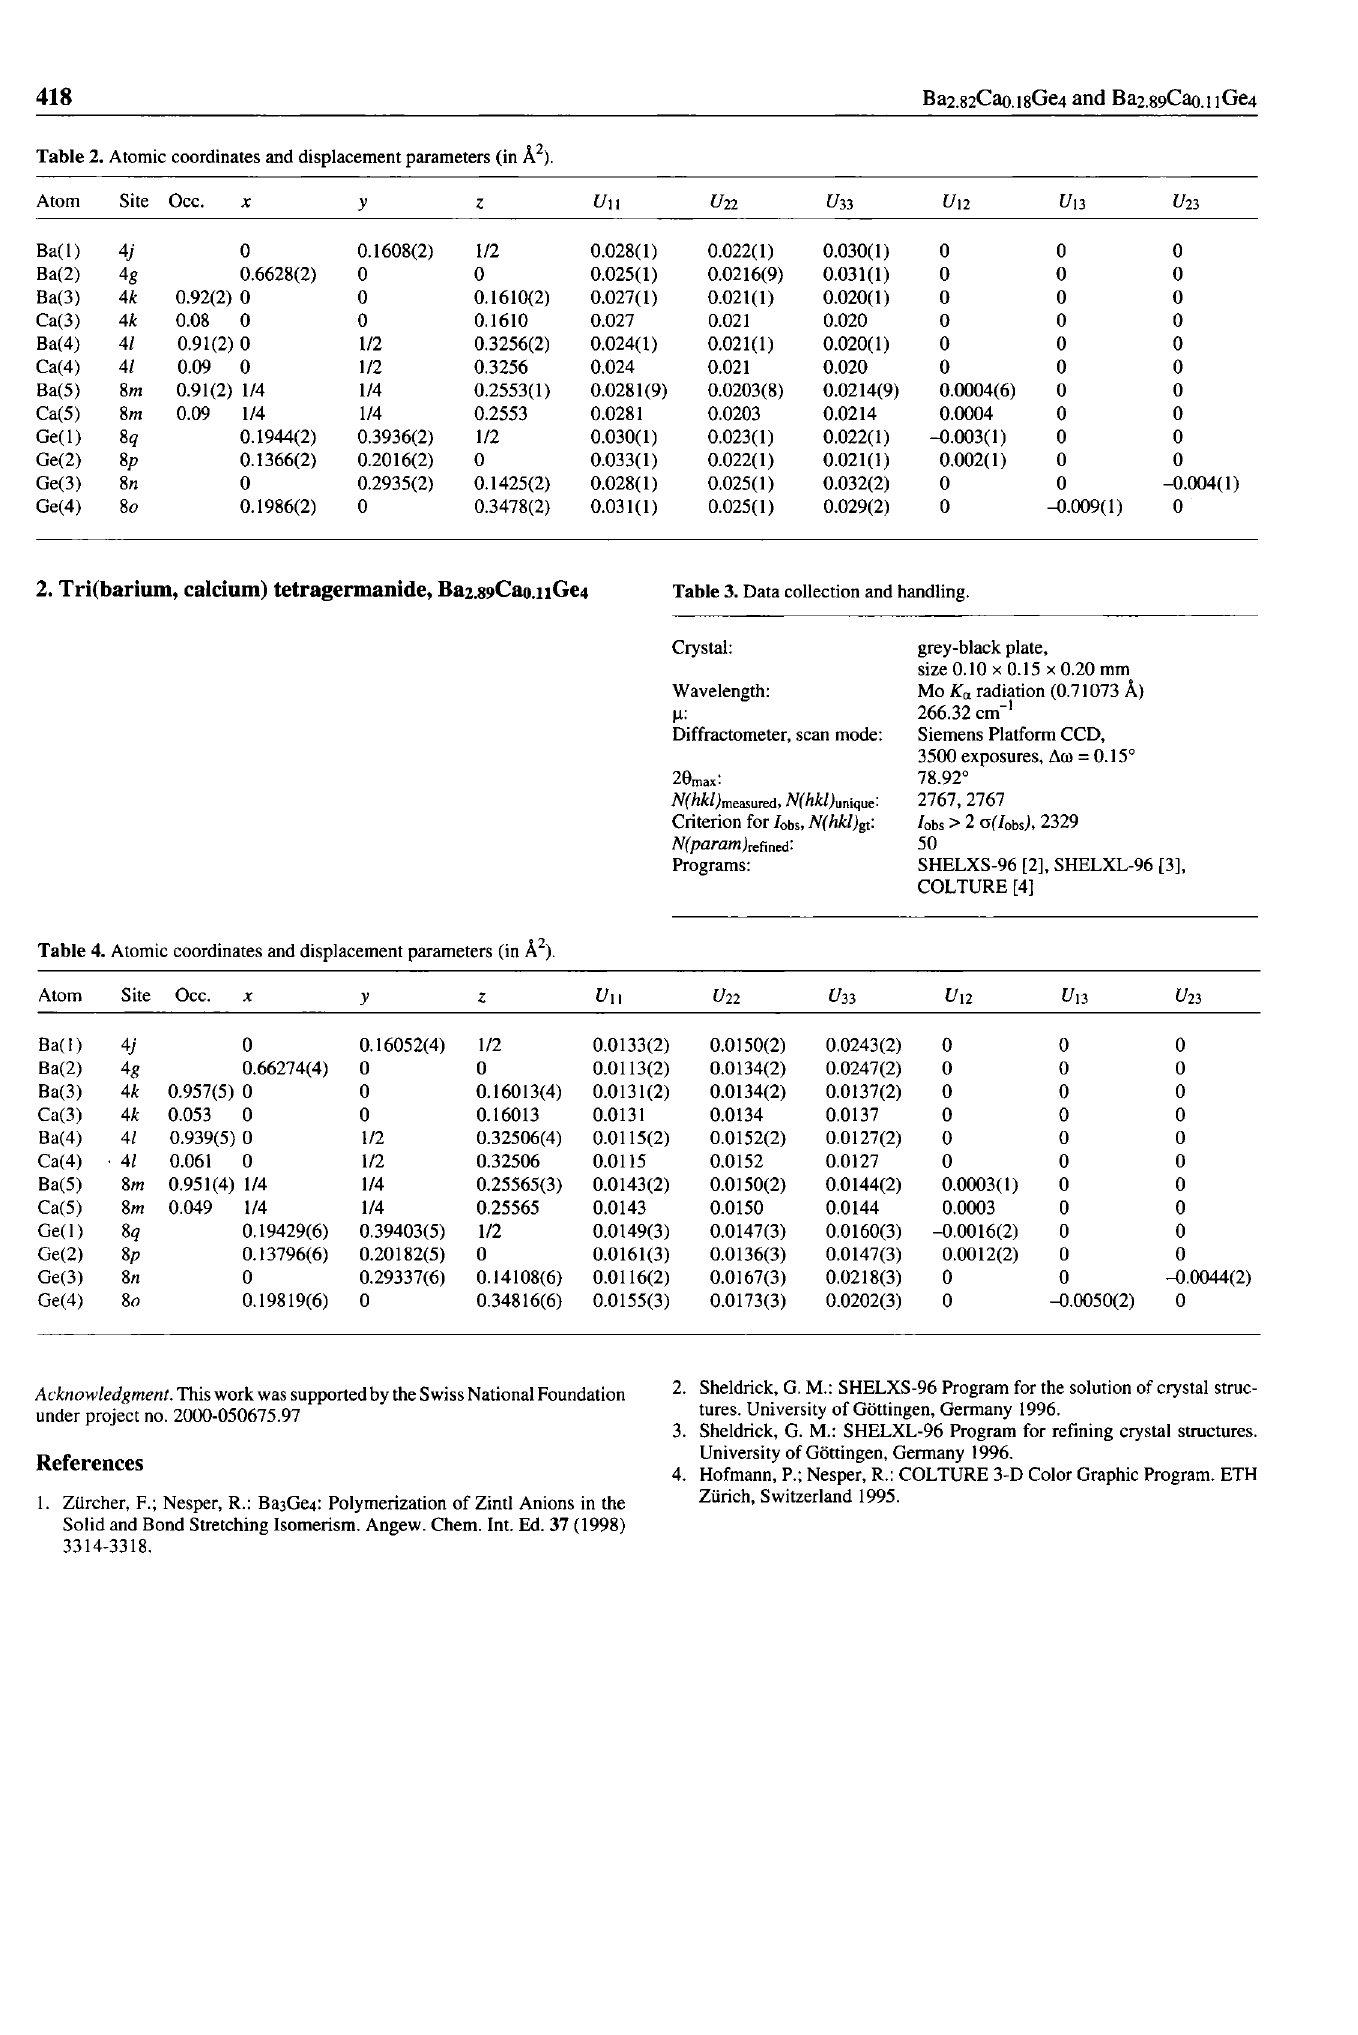
Table 3. Data collection and handling.